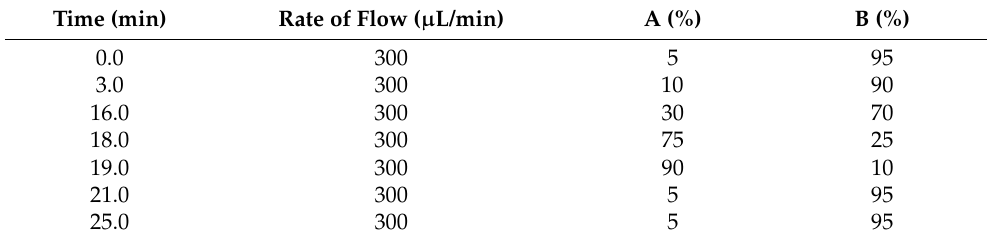
Table 1. Gradient elution